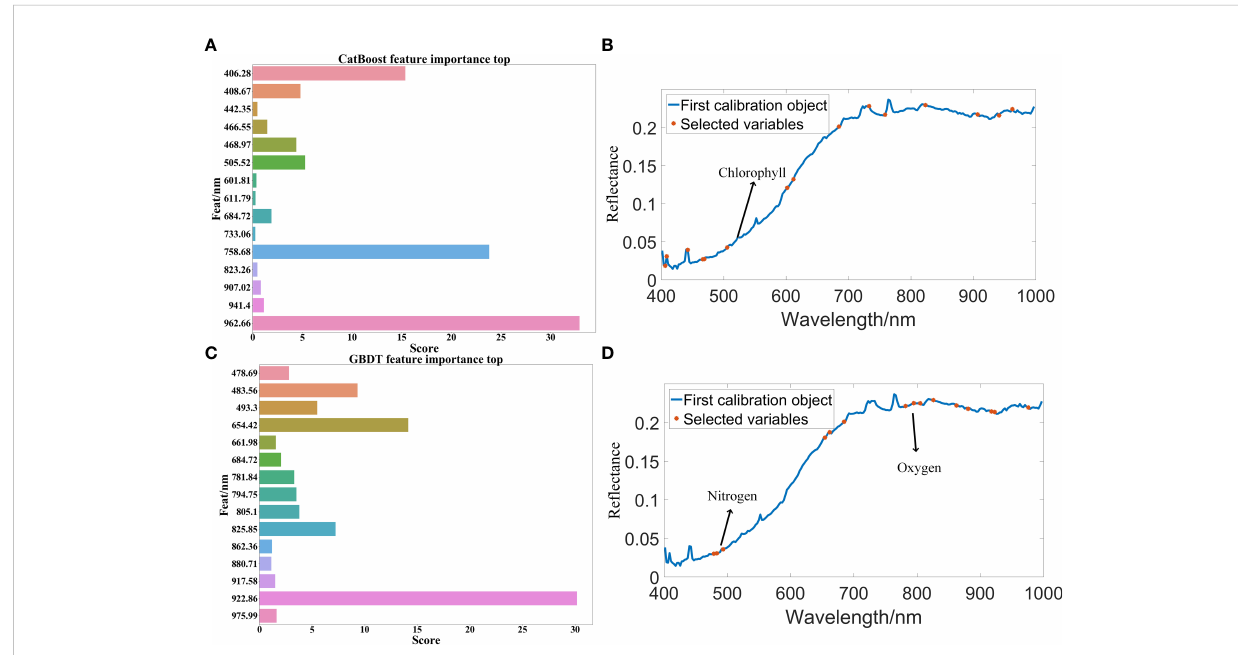
FIGURE 7 Regression model feature band extraction map: (A) CatBoost feature band extraction weight map; (B) CatBoost feature band extraction in all bands; (C) GBDT feature band extraction weight map; (D) GBDT feature band extraction in all bands.